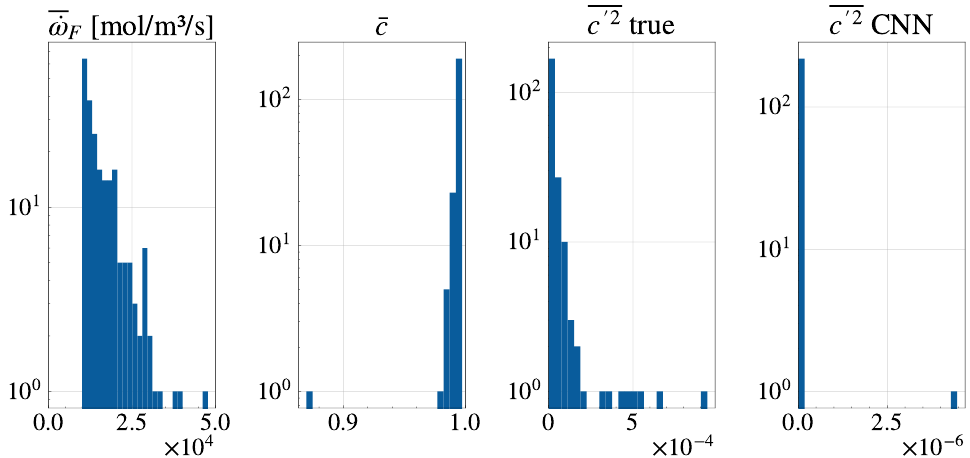
Figure 19. Histograms of ˙ ω F , ¯ c , true c (cid:48) 2 , and CNN c (cid:48) 2 for the points in the reaction zone where the PB-CNN reaction rate is exactly zero.